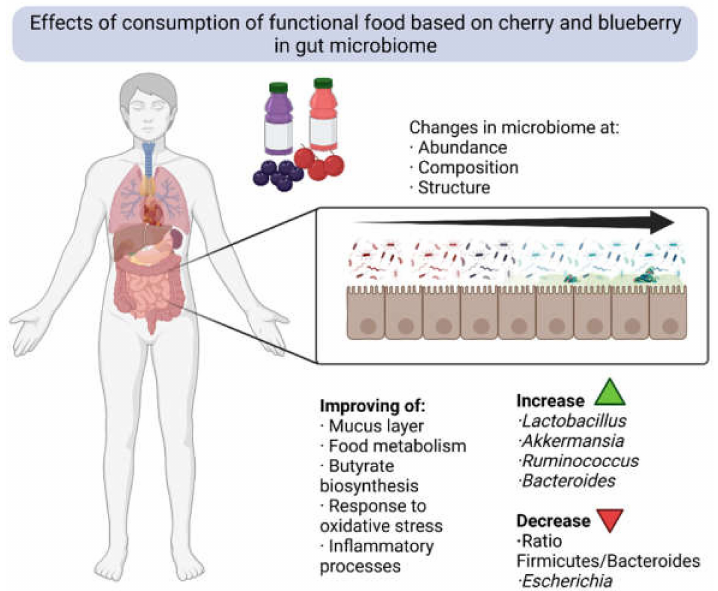
Figure 6. Main effects of functional beverages based on cherry and blueberry in dynamics and functionality of gut